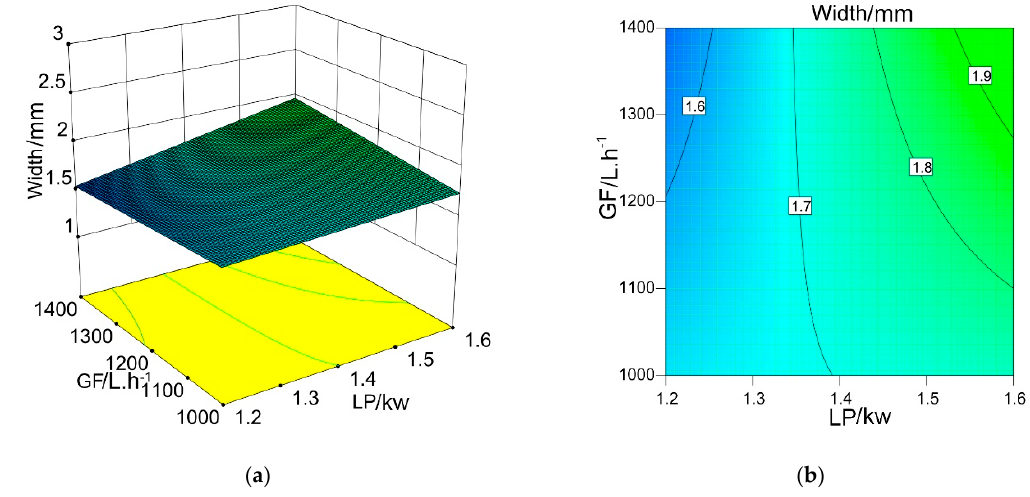
Figure 6. ( a ) 3D response surface showing the influence of laser power and gas flow on clad width. ( b ) Contour line of the response surface.